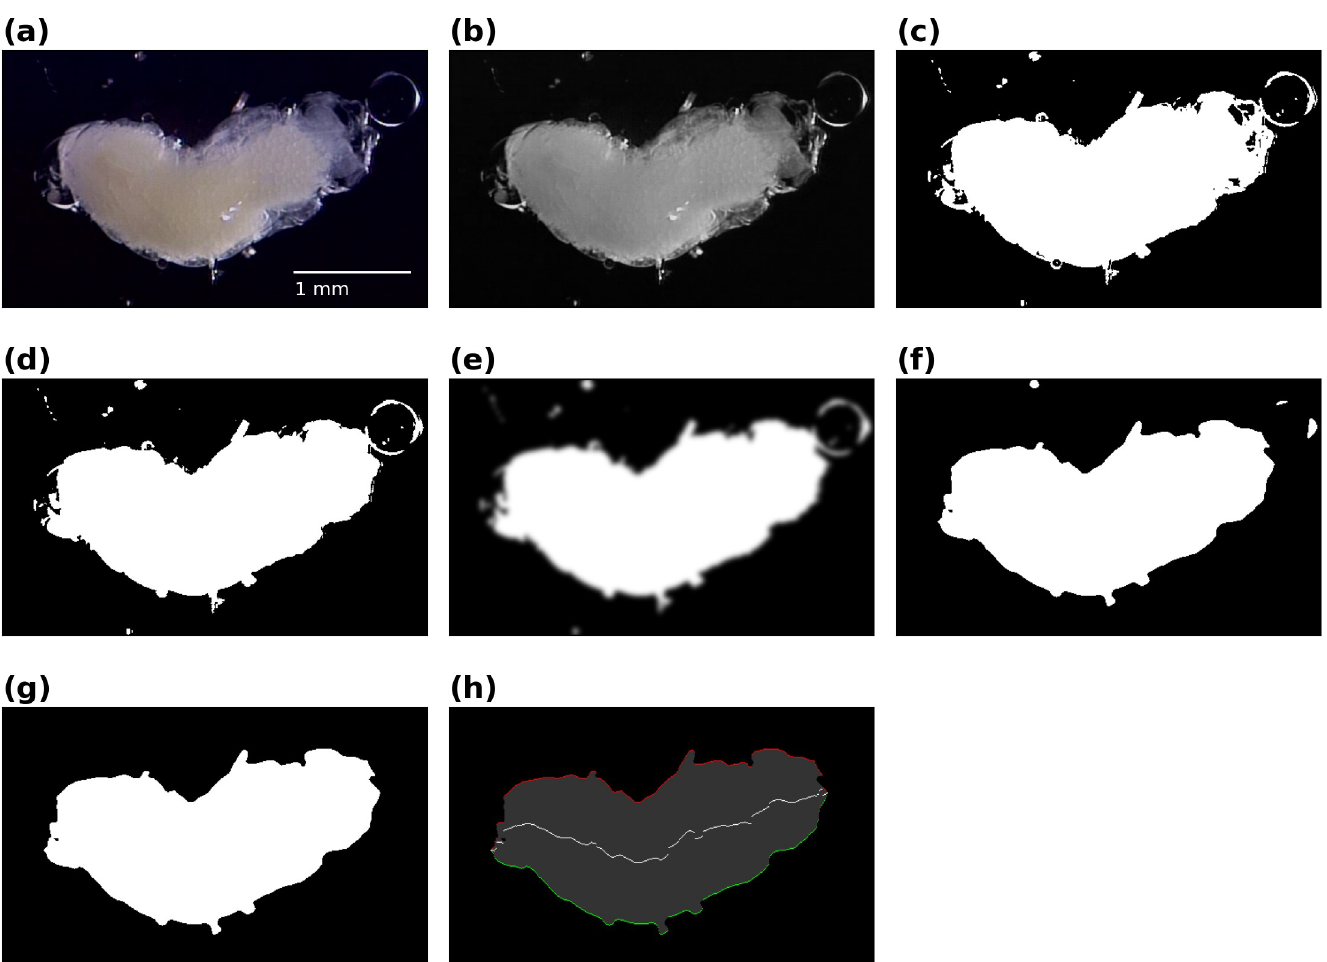
Fig 9. Midline computation. Sequence of image processing steps used to compute the midline of the pupa for every frame of the video. A RGB video frame is extracted (a) and converted to a grayscale image (b) , then thresholded (c), and holes are then removed (d) . Blob borders are softened by applying a gaussian filter (e) and thresholded again (f) . Small blobs are discarded (g) and the left (green) and right (red) borders are computed (h) . The mean of the two borders represents the midline (white line).